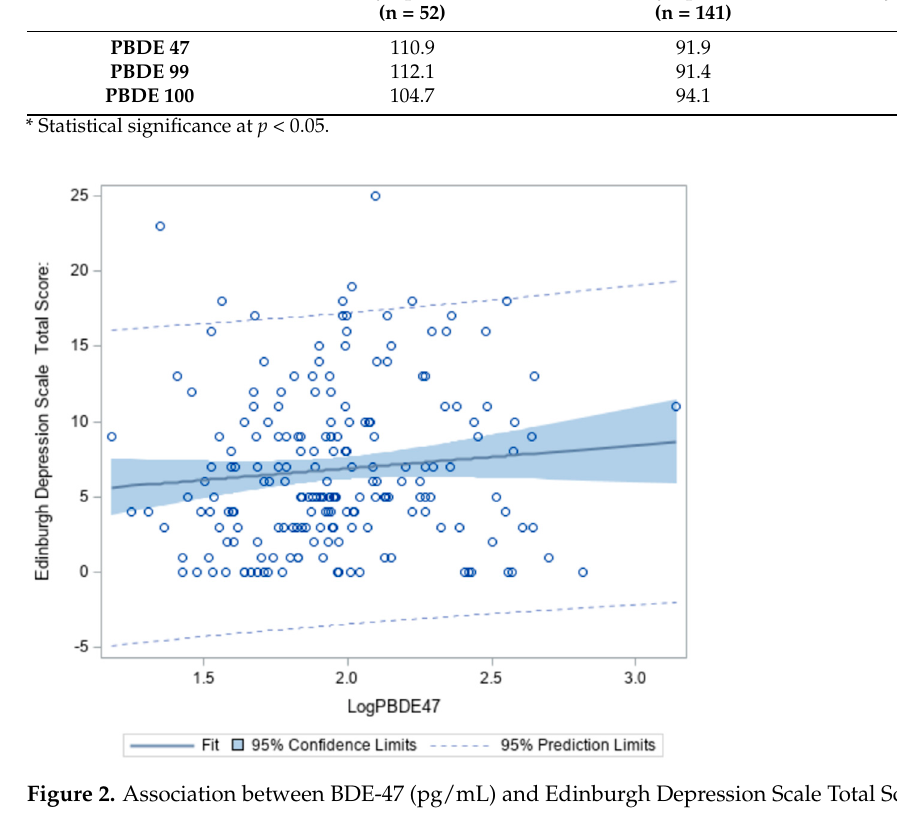
Table 5. PBDE concentrations and high antenatal depression risk among. African American preg- nant women (cutoff ≥ 10).